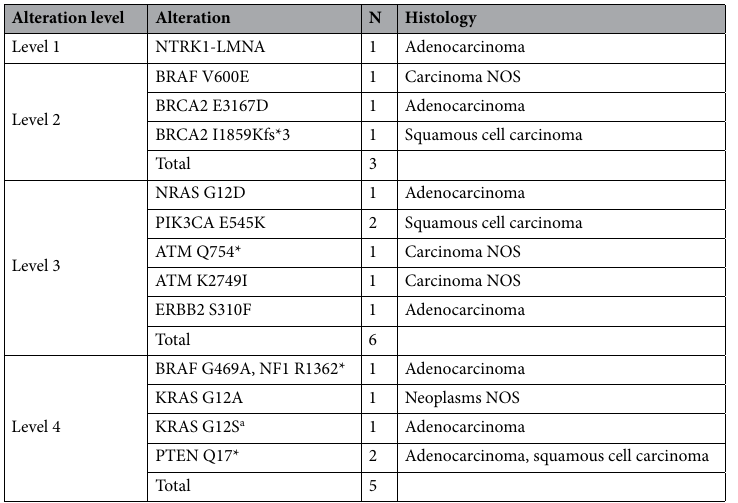
Table 2. Level 2, 3, and 4 alterations in patients with CUP. Reference 23 . NOS not otherwise specified. a Also has ERBB2-PPP1R1B (level 2 alteration).